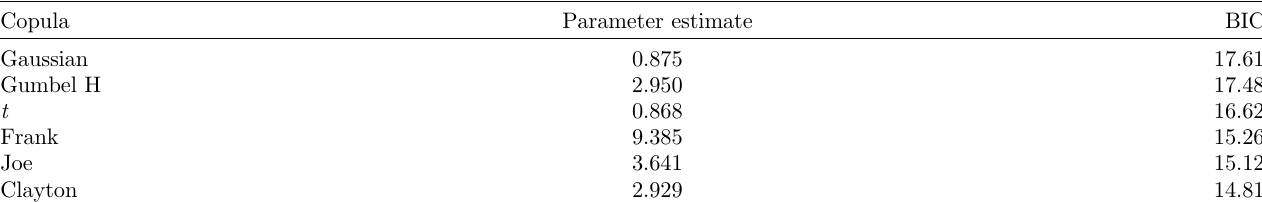
Table 1. Parameters estimated by Maximum Log-Likelihood (MLL) and BIC values for the copula between the pseudo-observations ranks ( V T ) and ranks ( V F ); degrees of t -Student ^ g = 3.529 also estimated by MLL using the tCopula() function of the copula R-package.